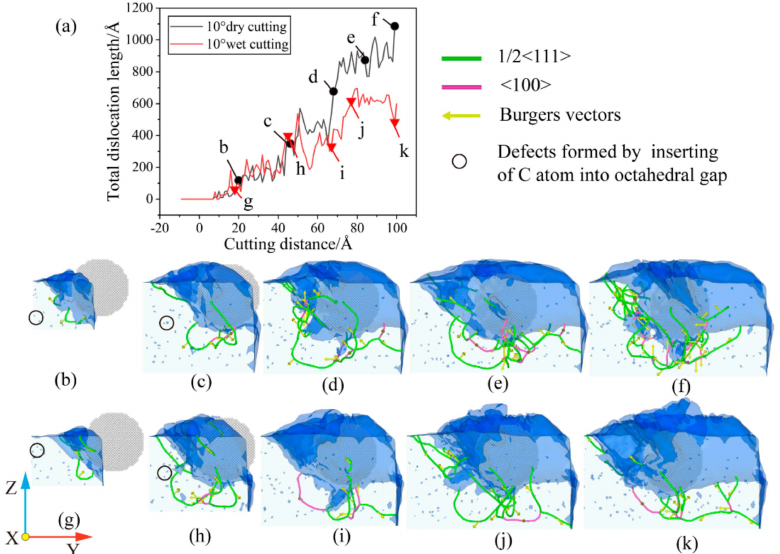
Figure 15. Dislocation evolution under θ = 10 ◦ . ( a ) Variation of total length of dislocation with cutting distance; ( b ) cutting distance of 20 Å under dry cutting; ( c ) cutting distance of 46 Å under dry cutting; ( d ) cutting distance of 68 Å under dry cutting; ( e ) cutting distance of 86 Å under dry cutting; ( f ) cutting distance of 100 Å under dry cutting; ( g ) cutting distance of 16 Å under wet cutting; ( h ) cutting distance of 45 Å under wet cutting; ( i ) cutting distance of 66 Å under wet cutting; ( j ) cutting distance of 77 Å under wet cutting; and ( k ) cutting distance of 99 Å under wet